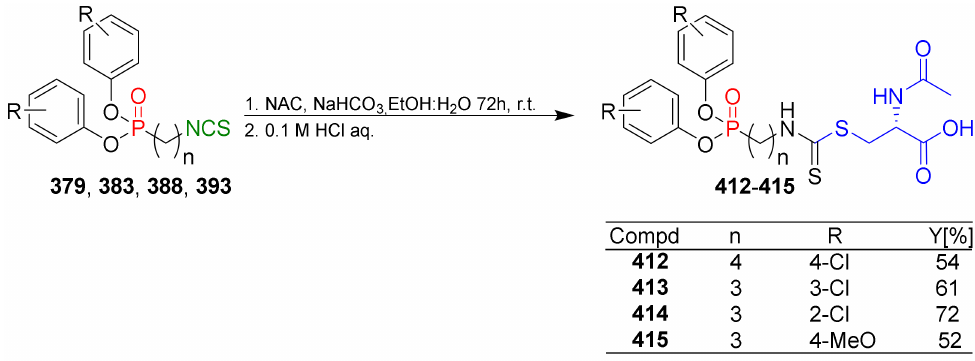
Figure 44. Preparation of phosphonates isothiocyanate-derived mercapturic acids 412 – 415